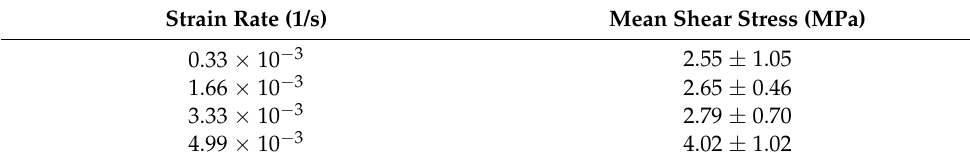
Table 5. Nominal shear stress at different strain rates, category B.